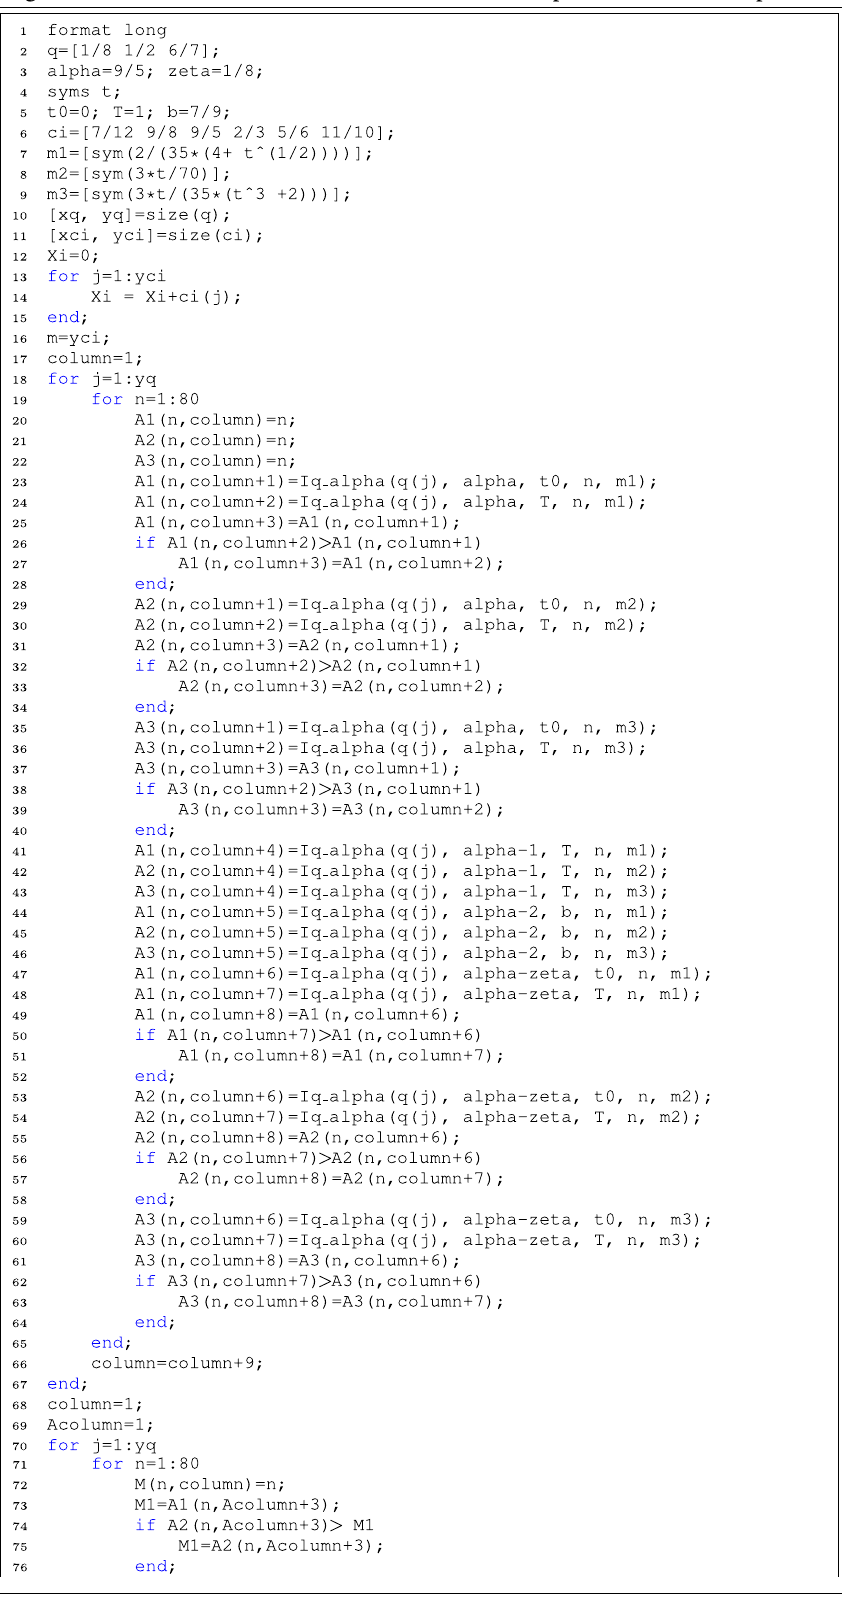
Algorithm 7 The MATLAB lines for calculation of all parameters in Example